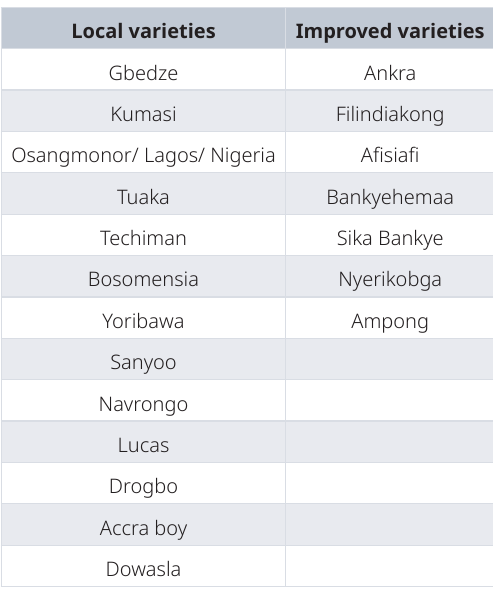
Table 7. Names of varieties cultivated in the study